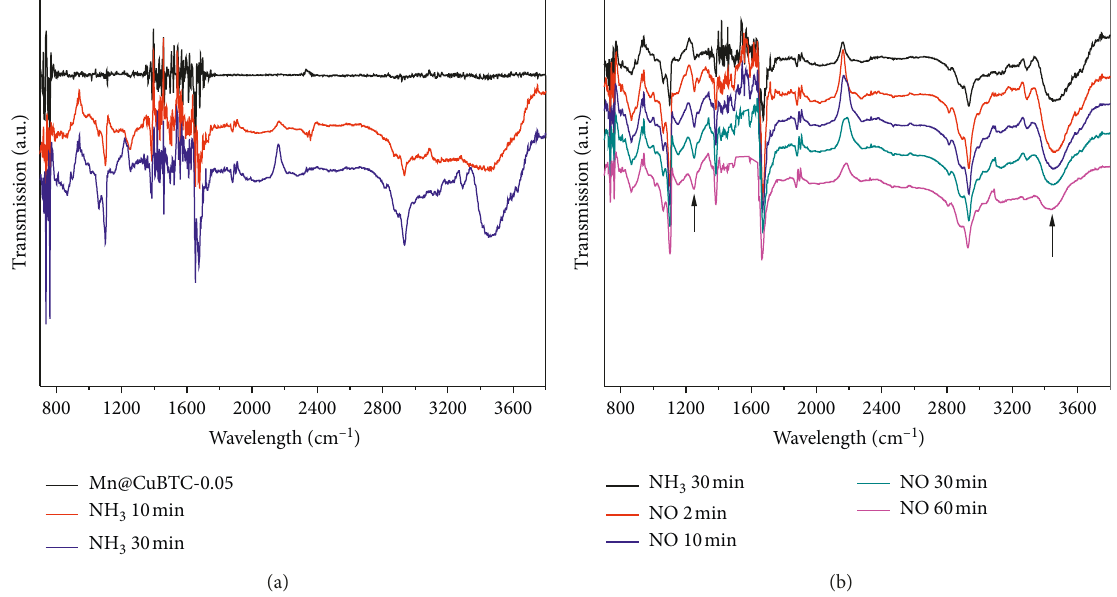
Figure 7: In situ DRIFTspectra of activated Mn@CuBTC-0.05 (a) exposed to NH exposure. Reaction condition: [NH 3 ] � 500ppm, and N 2 balance; (b) exposed to NO+O 2 at 230 ° C for various times after NH 3 adsorption and purged with N 2 . Reaction condition: [NO] � 500ppm, [O 2 ] � 5% and N 2